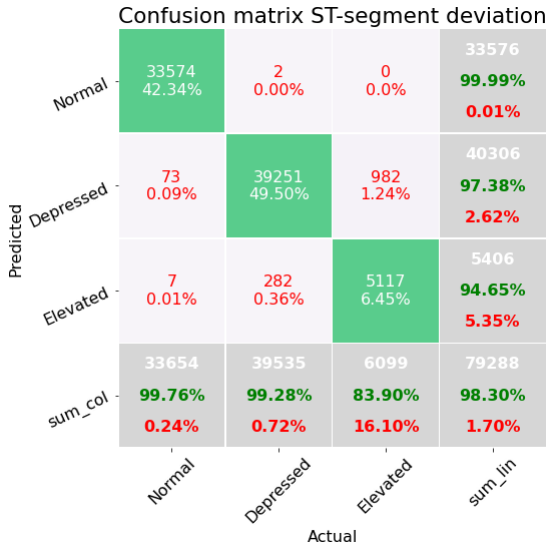
Figure 7. Confusion matrix on the modeling containing the features concerning statistical measures and SQIs of the ECG